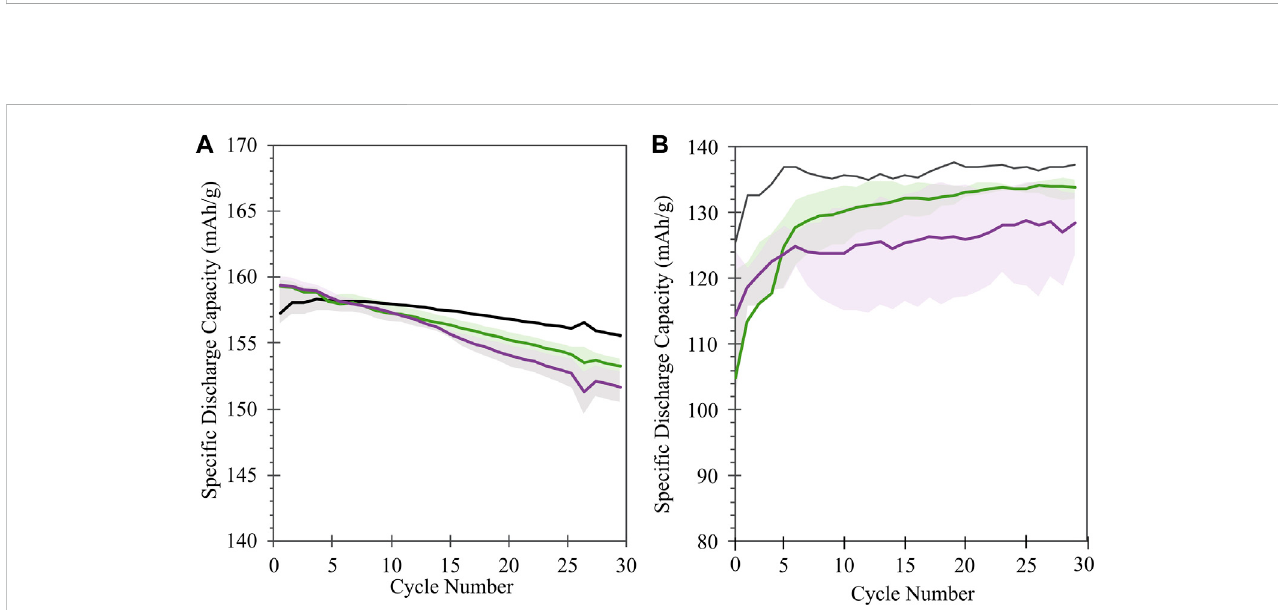
FIGURE 5 (A) Half cell and (B) full cell cycling performance of NMC samples: pristine (black) or following treatment in KOH (green) or KOH + KCl (purple) matrix. Shaded regions re fl ect the range of performance from equivalent sample replicates for each condition; solid lines re fl ect the average value across replicates.